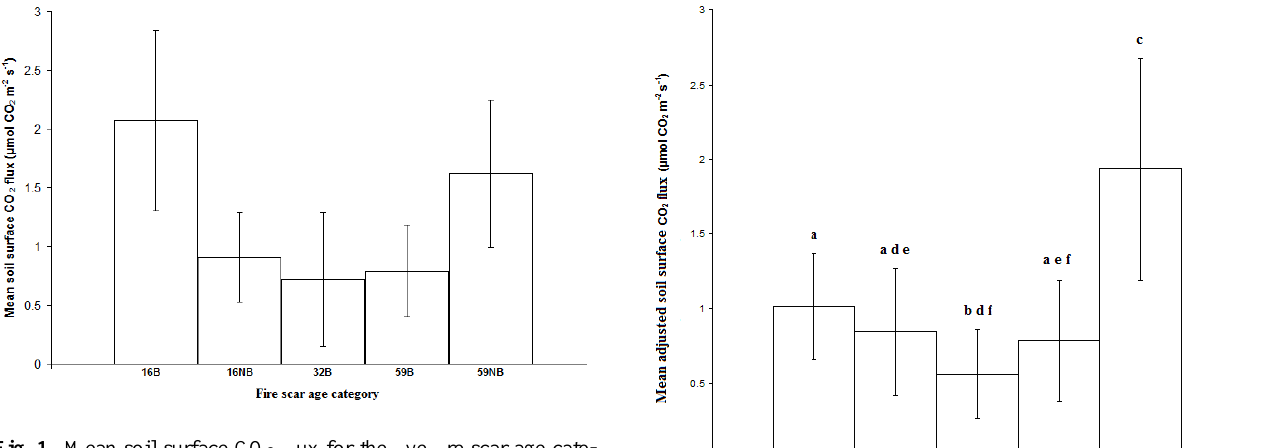
Fig. 1. Mean soil surface CO 2 flux for the five fire scar age cate- gories at Sharpsand Creek. Error bars represent ± 1 standard devi- ation of the mean.